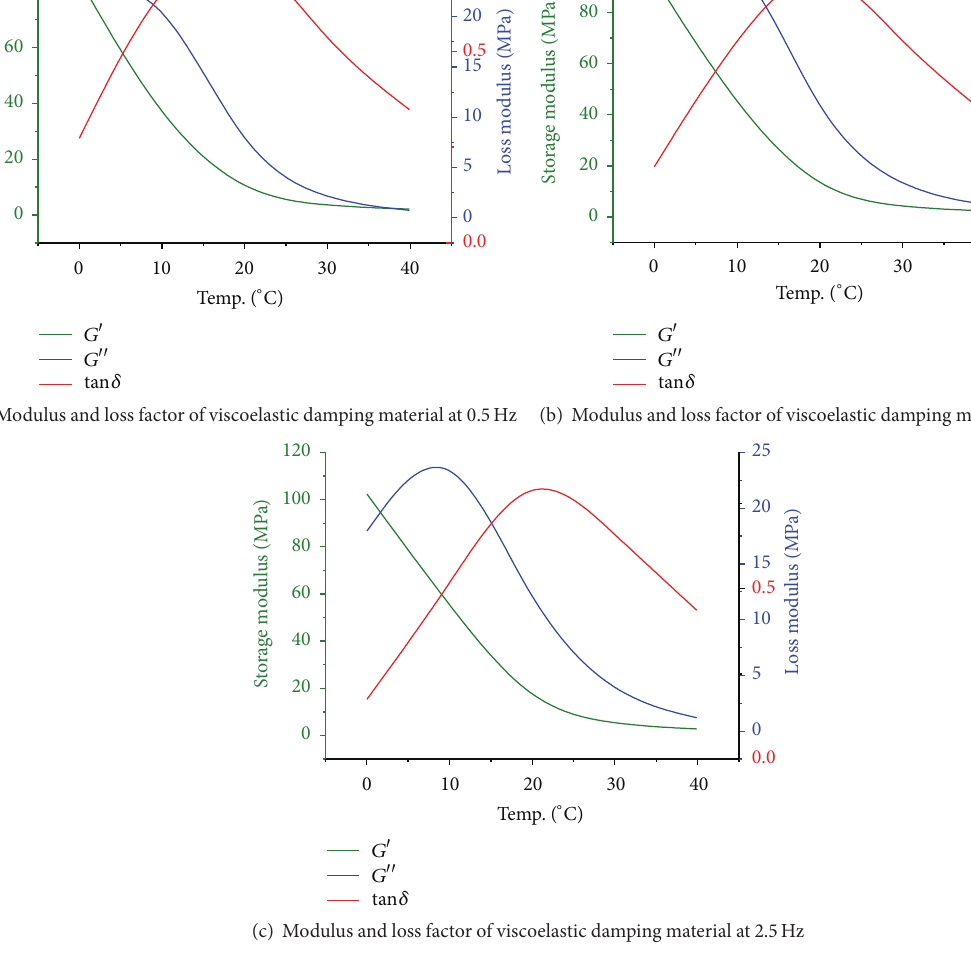
Figure 2: Basic mechanical property of viscoelastic damping material.